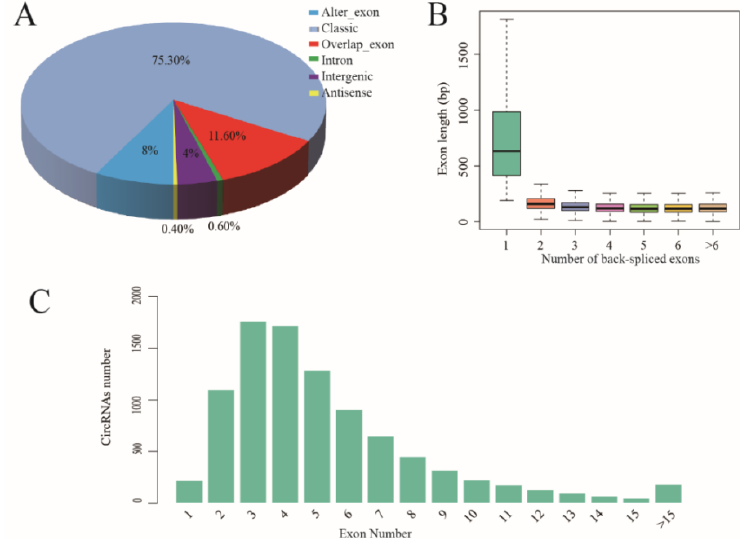
Figure 1. General characteristics of circRNAs in the sheep uteri. ( A ) Percentages of the six types of circRNAs. ( B ) Exon length distribution of cricRNAs. ( C ) Number of exons per transcript of sheep circRNA.